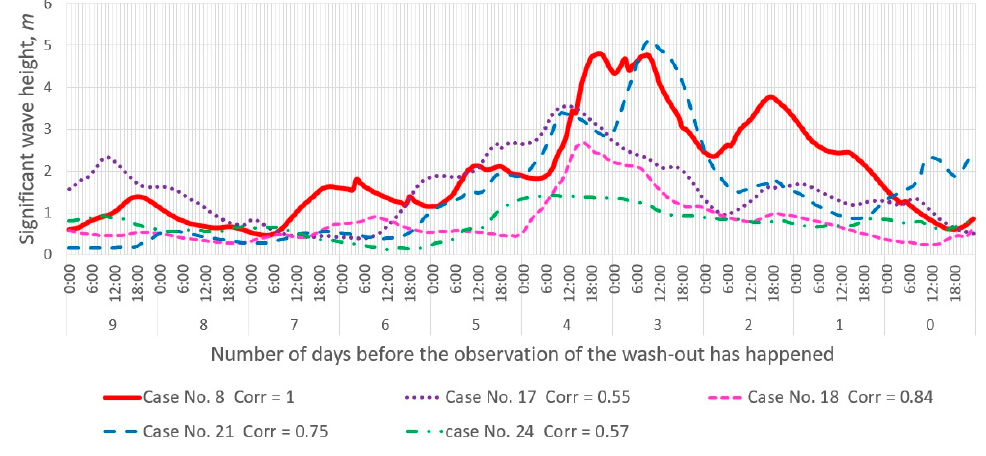
Figure 7. Variations in the significant wave height for cases No. 8, 17, 18, 21, and 24 10 days before the wash-out event. The curves are synchronized using the time of the wash-out event (right-hand side, day 0). Coefficients of correlation with the development of wave situation are shown relatively occasions case No.